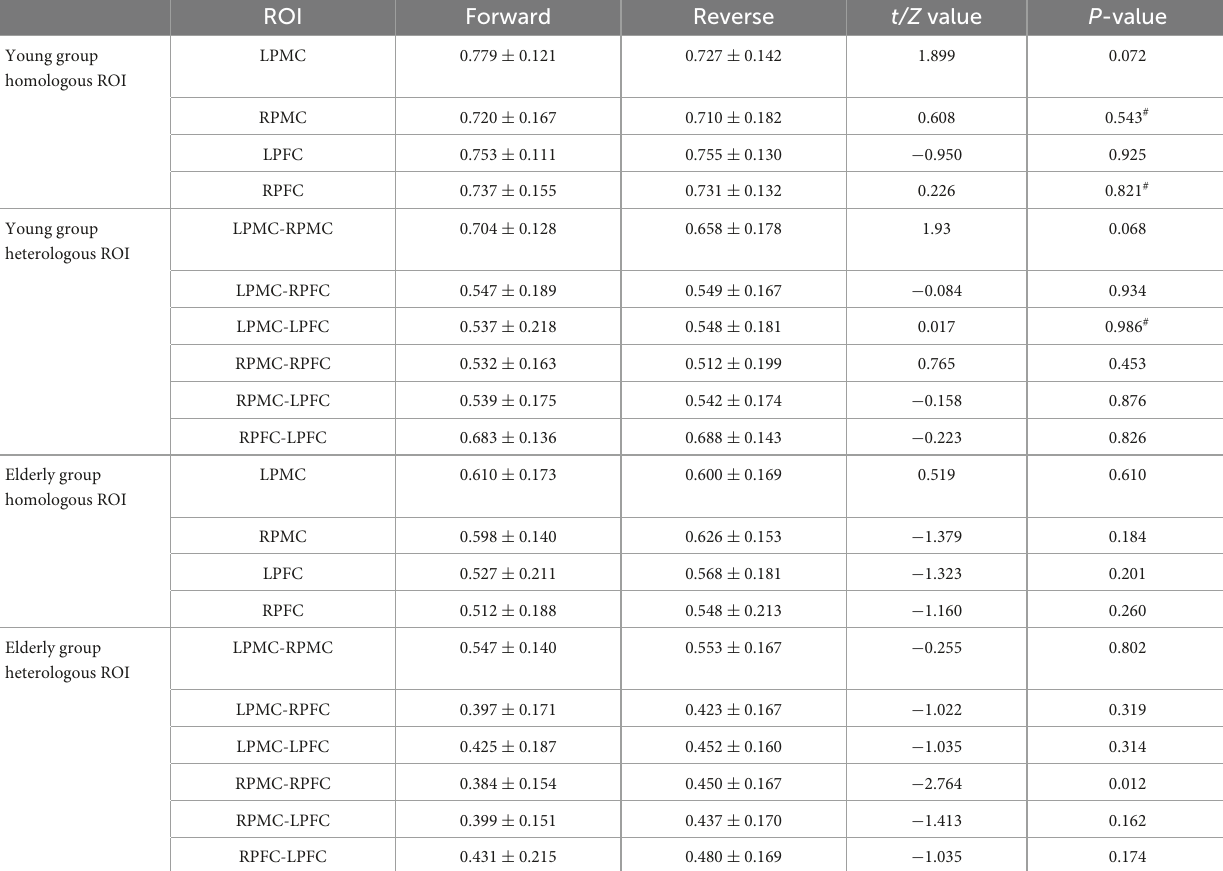
TABLE 5 Intra-group differences of functional connectivity (FC) values of brain network in forward and reverse judgment tests. ROI Forward Reverse t/Z value P -value Young group homologous